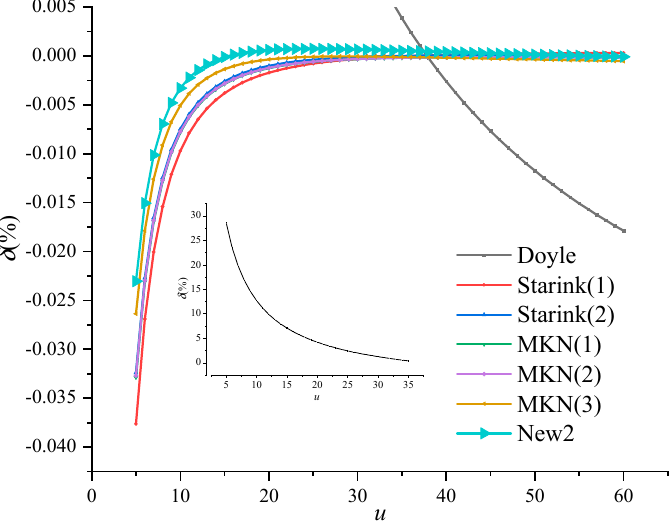
Figure 5. Percent deviation of activation energy of the temperature integral transformation. From step one of the basin insulator thermogravimetric curve, the conversion rate α is selected to be between 0.2 and 0.8 with an interval of 0.1. At the same conversion rate, different heating rates are substituted into Equation (19), and the average activation energy corresponding to different conversion rates is 86 ( ± 4) kJ/mol. By repeating the above steps based on the improved activation energy calculation method, the average activation energy of the reaction step II of the basin insulator is 171 ( ± 6) kJ/mol. If the average of the sum of the activation energies, including reaction step one and reaction step two, is defined as the average activation energy of the total reaction, then the average activation energy value of the total reaction is 129 ( ± 5)